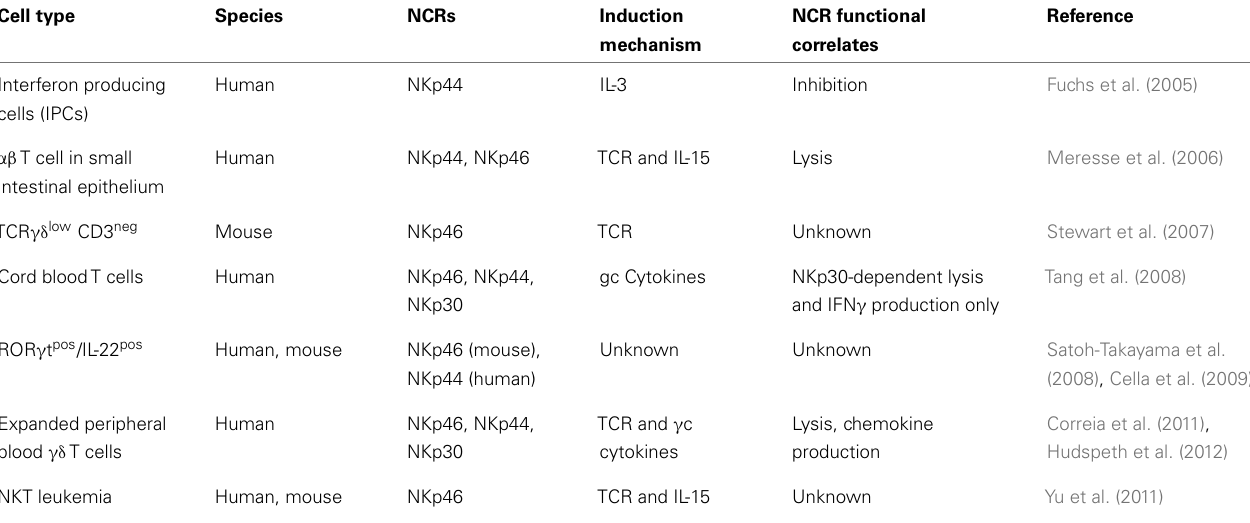
Table 1 | Distinctive hallmarks of NCRs since the discovery of NK